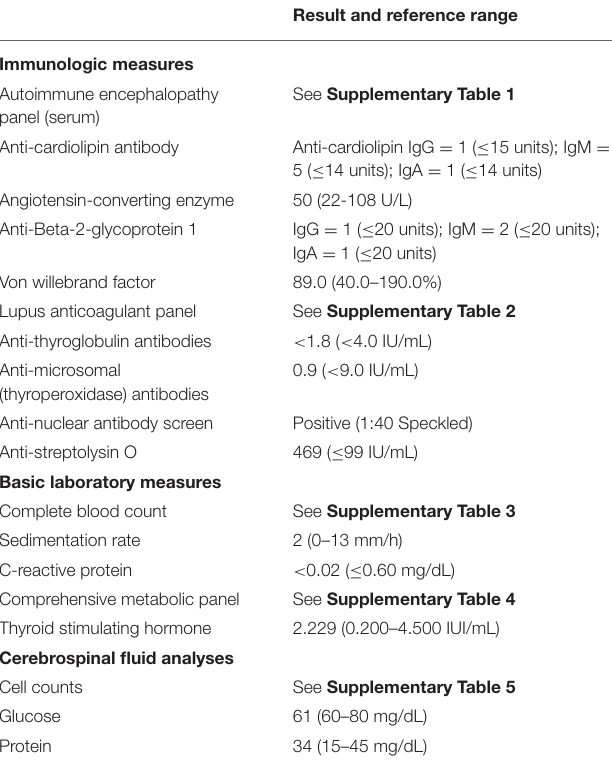
TABLE 1 | Immunological evaluation of a patient with Down syndrome disintegrative disorder. Result and reference